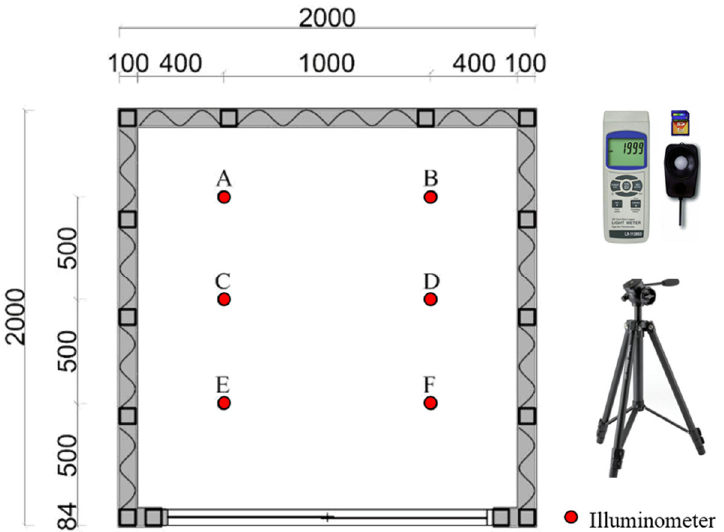
Figure 6. Measurement configuration of lighting experiment.